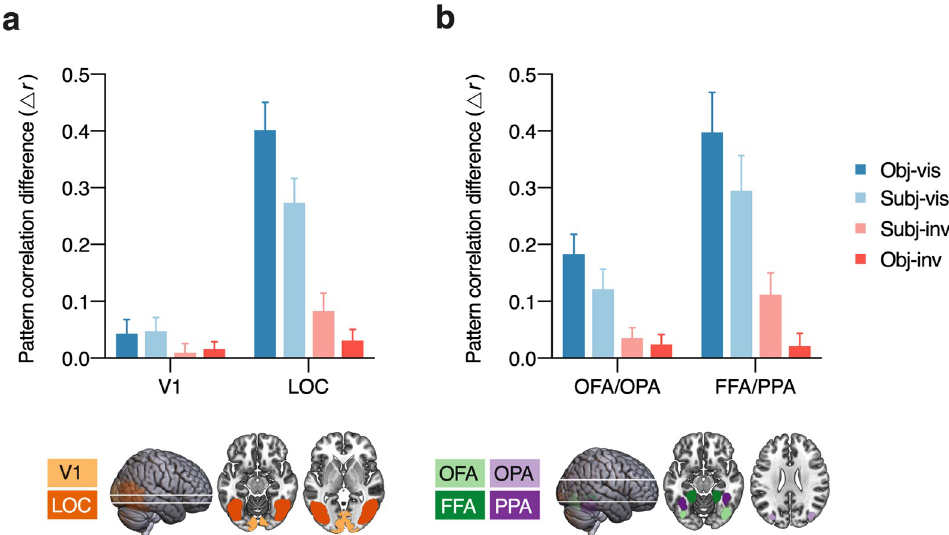
Fig 2. Category information across regions in visual cortex. Multivoxel pattern correlations between the 4 visibility conditions in the main experiment and the independent localizer. Bars show the mean difference between within- category and between-category multivoxel pattern correlations ( Δ r ). Error bars represent 95% confidence intervals. (a) Results for early visual cortex (V1) vs. object-selective visual cortex (LOC). (b) Results for posterior category-selective areas (OFA/OPA) vs. anterior category-selective areas (FFA/PPA). Data underlying this figure are available on OSF (https://osf.io/qus5v/). FFA, fusiform face area; LOC, lateral occipital complex; OFA, occipital face area; OPA, occipital place area; PPA, parahippocampal place area; V1, primary visual